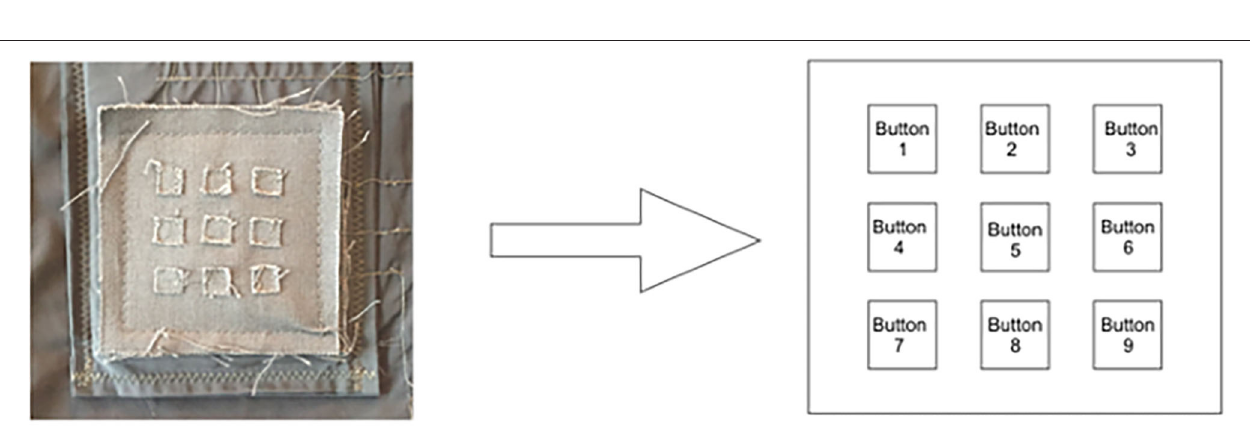
FIGURE 9 | Schematic of the matrix with the mapping of the buttons; left: picture of the matrix sewn into the second version of the vest; right: the distribution of buttons in the matrix.